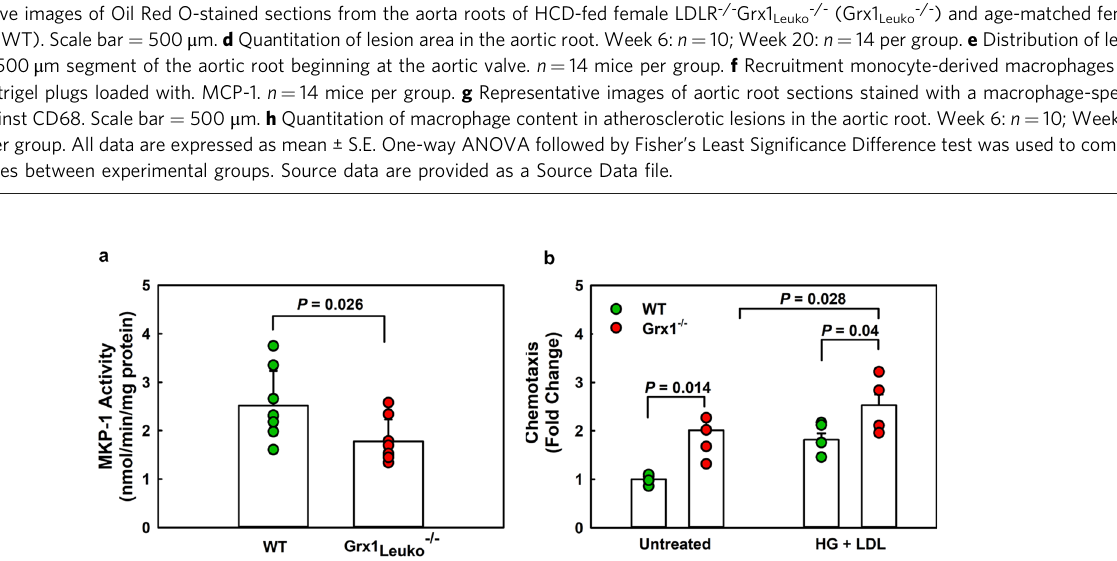
Fig. 9 Hematopoietic Grx1 de fi ciency exacerbates nutrient stress-induced monocyte dysfunction. a MKP-1 activity in puri fi ed peritoneal macrophages isolated from HCD-fed female LDLR -/- Grx1 Leuko -/- mice (Grx1 Leuko -/- ) and age-matched female LDLR -/- mice (WT). n = 15 mice per group. b Chemotaxis of puri fi ed peritoneal macrophages isolated from female Grx1 Leuko -/- and age-matched C57BL/6 mice (WT). n = 4 mice per group. All data are expressed as mean ± S.D. One-way ANOVA followed by Fisher ’ s Least Signi fi cance Difference test were used to compare the mean values between experimental groups. Source data are provided as a Source Data fi